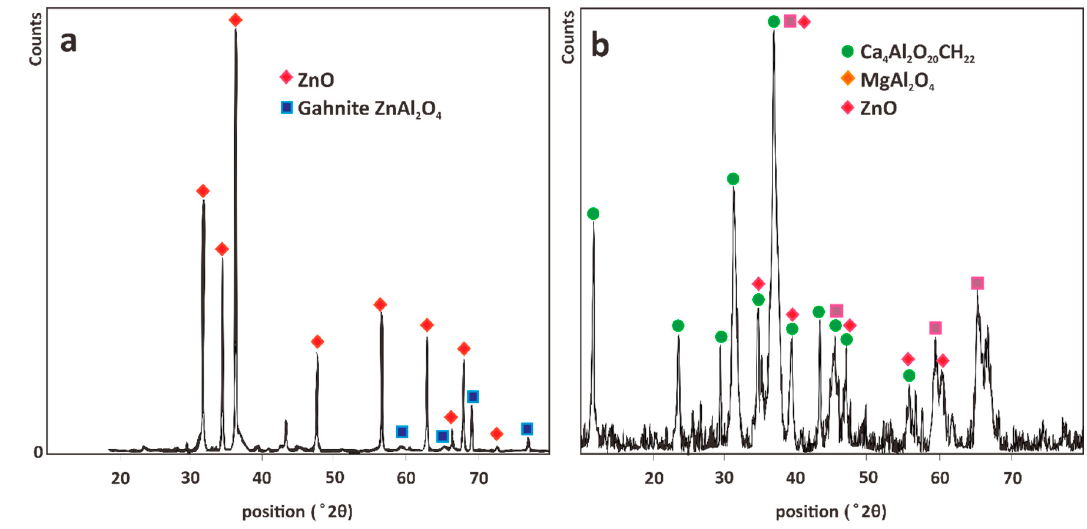
Figure 2. Phases present in EAF dust ( a ) before and ( b ) after leaching.